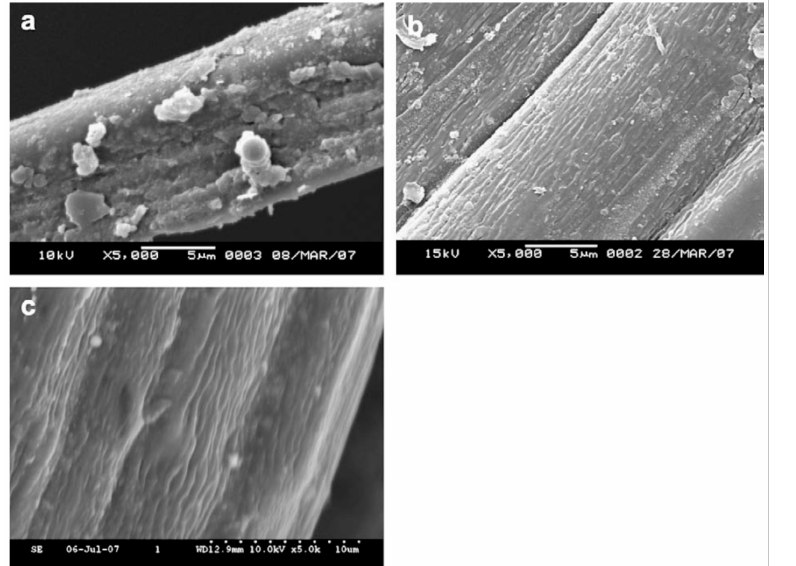
Figure 10. Different methods for fiber modification.